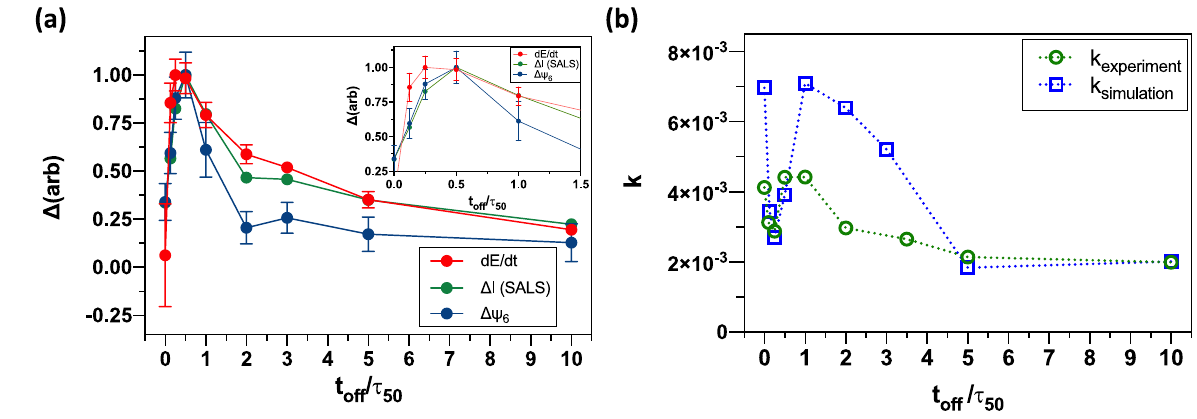
Figure 5. Performance and kinetics of colloidal crystals annealing as a function of melting time ratio t off /τ 50 . ( a ) Relative changes of system order parameters as a function of t off /τ 50 for simulated systems. The difference of local order ( ψ 6 ) and global order ( I ) are shown alongside rate of energy exchange with the Langevin thermostat. ( I is measured by simulated SALS.) The change in ψ 6 is most sharply peaked around t off /τ 50 = 0.5. SALS peak intensity shows a somewhat broader peak distribution. Energy exchange rate with the thermostat is also broad; it furthermore shows a shift in peak position to t off /τ 50 = 0.25 (inset). ( b ) Relative changes of annealing rate constant k as a function of t off /τ 50 for both simulated systems and experiments. Here k has units of s −1